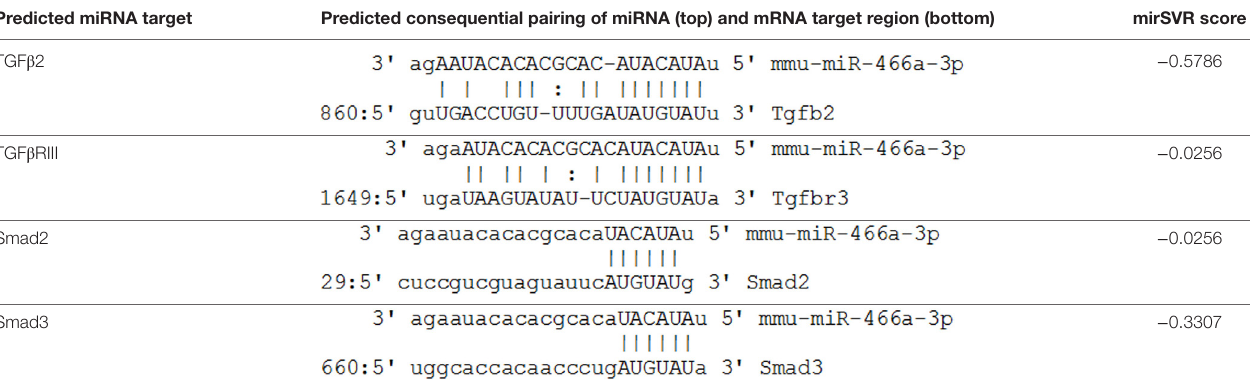
TaBle 2 | The predicted miRNA–mRNA binding interaction between indicated mRNA and miR-466a-3p, along with the associated mirSVR score for that